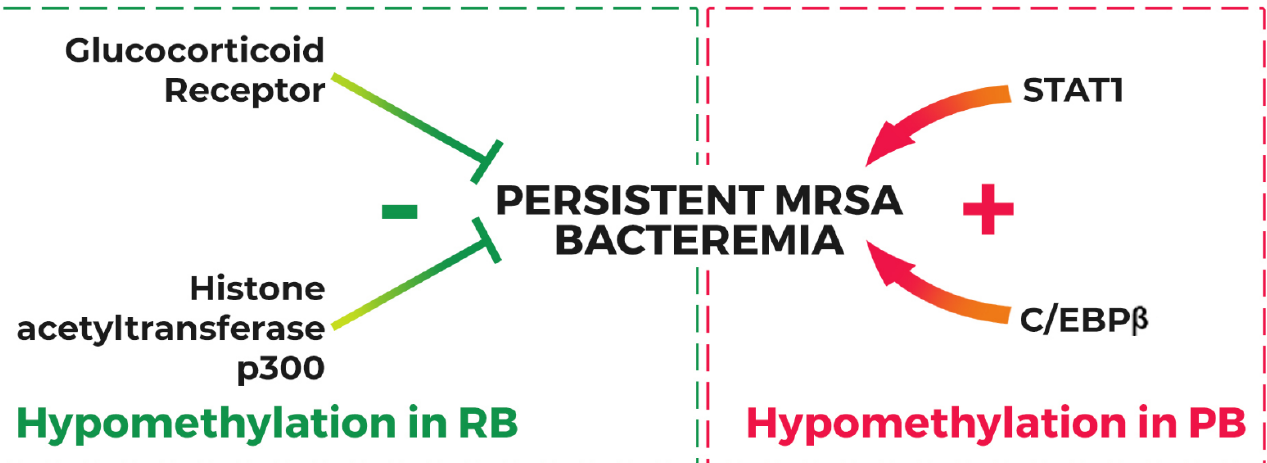
Figure 2. Schematic showing genes with hypomethylation in patients with persistent MRSA bacteremia (PB) and resolving MRSA bacteremia (RB).